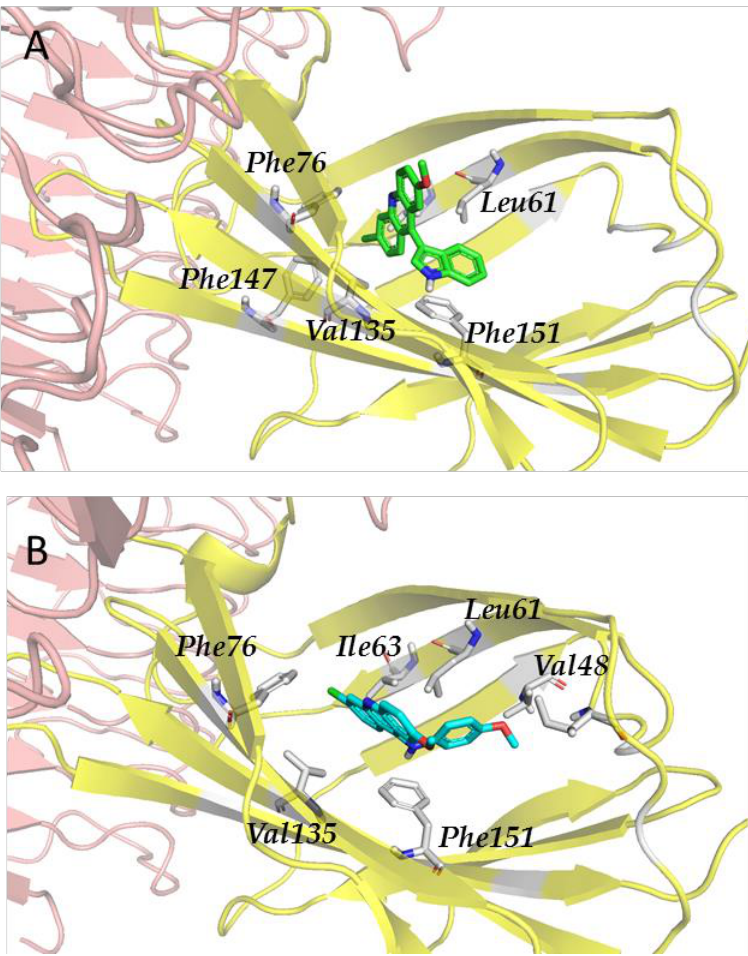
Figure 5. Redocked MS-21 (( A ), green sticks) and MS-32 (( B ), cyan sticks) in TLR4/MD2. TLR4 is depicted in pale pink; MD-2 — in yellow. MD-2 interacting residues are highlighted with grey sticks.